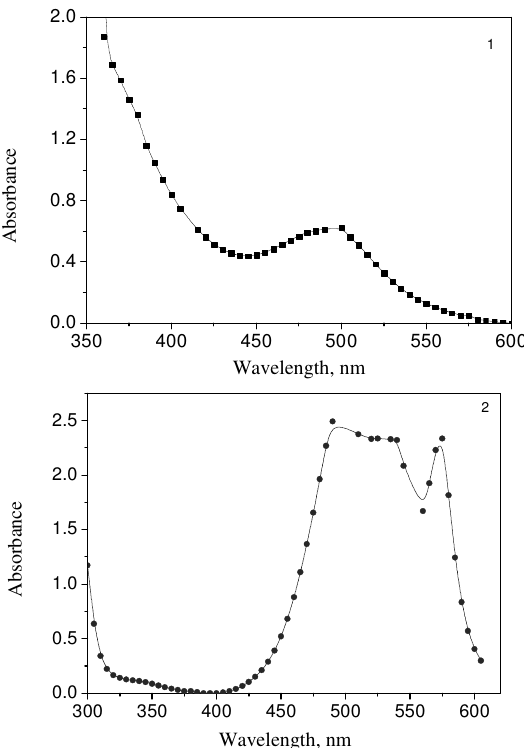
Figure 2 . Absorption spectra of the developed complex associates [Tz] + .[BiI chloroform (1) and [Phen] + .[BiI